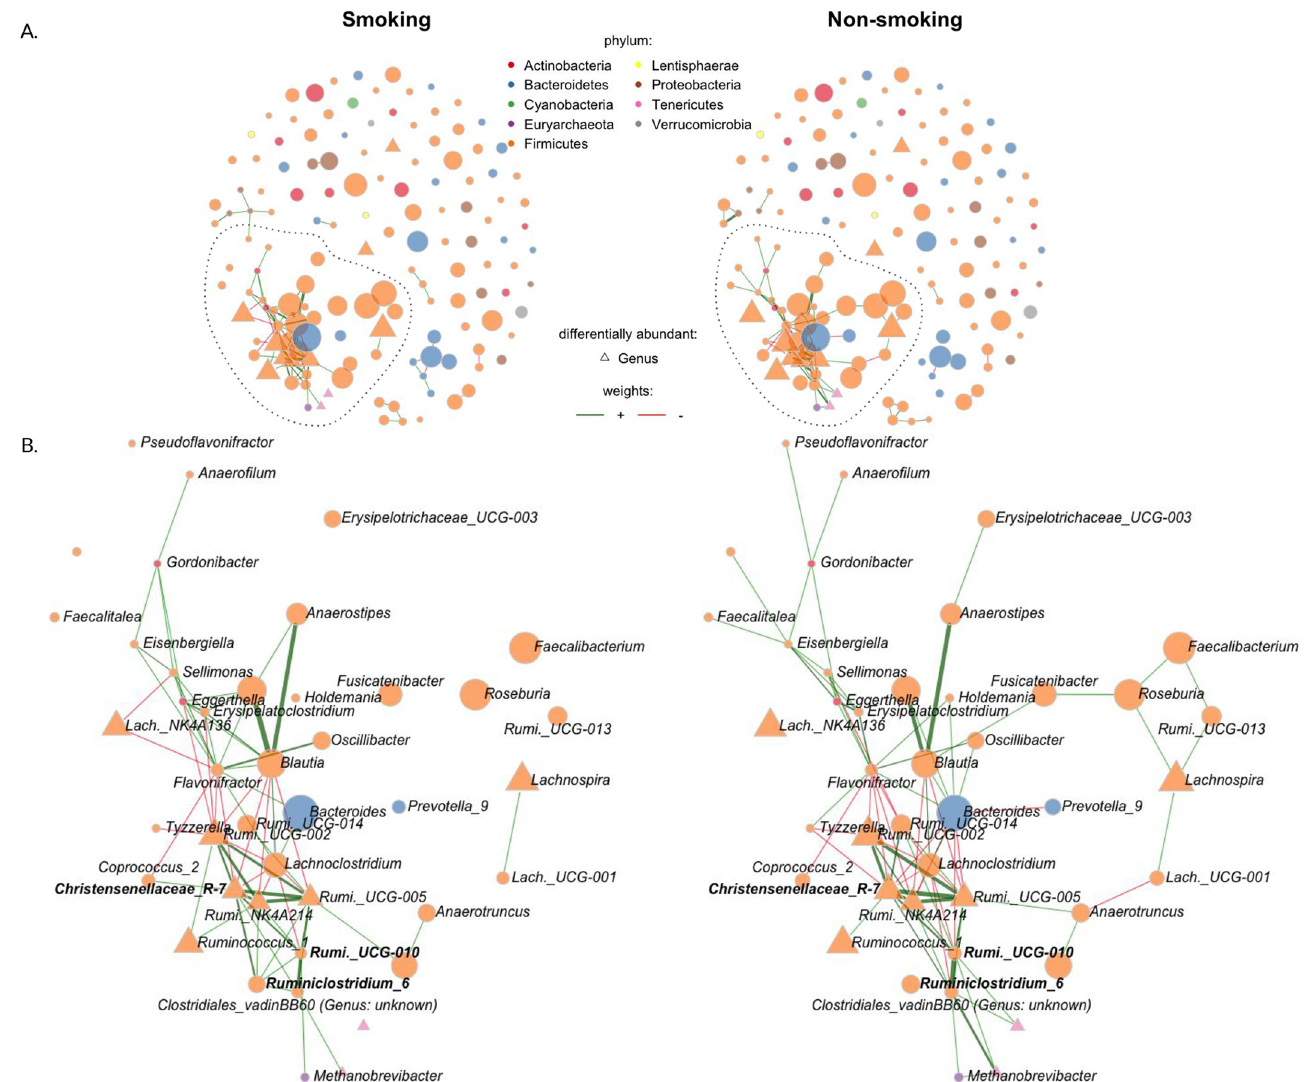
Fig 4. Genus-genus associations of smokers and never-smokers (n = 271, p = 140). (A) Visualization of the genus-genus partial correlations estimated with the SPIEC-EASI method. Edges thickness is proportional to partial correlation, and color to sign: red: negative partial correlation, green: positive partial correlation. Node size is proportional to the centered log ratio of the genus abundances, and color is according to phyla. Triangle shaped nodes are differentially abundant (see Fig 3). (B) Zoom in largest connected component and differential associations (bold